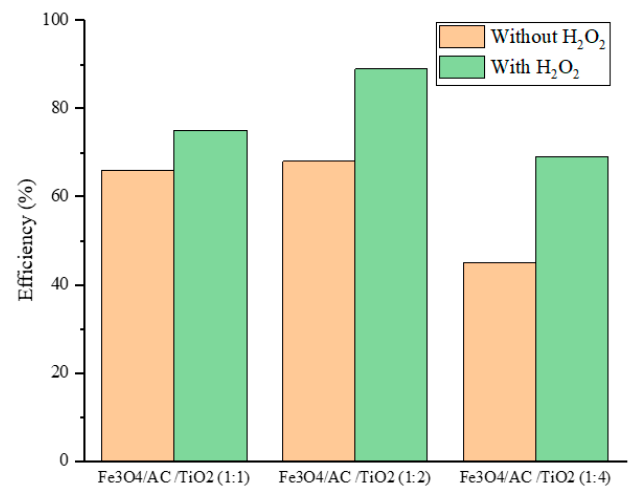
Figure 9. Effect of H 2 O 2 on the removal efficiency of MB under UV light at pH 12.